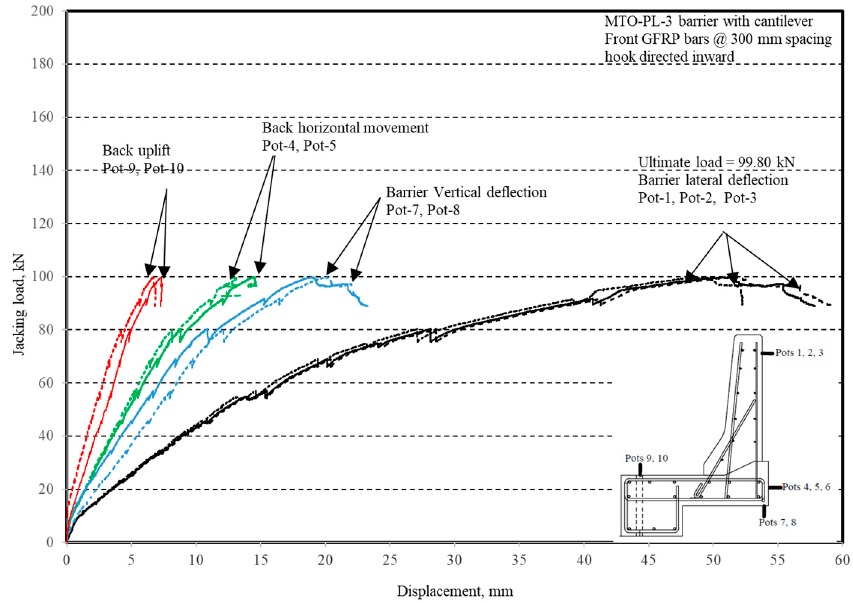
Figure 11. Specimen # 1: Load vs. displacement history. Materials 2019 , 12 , x FOR PEER REVIEW